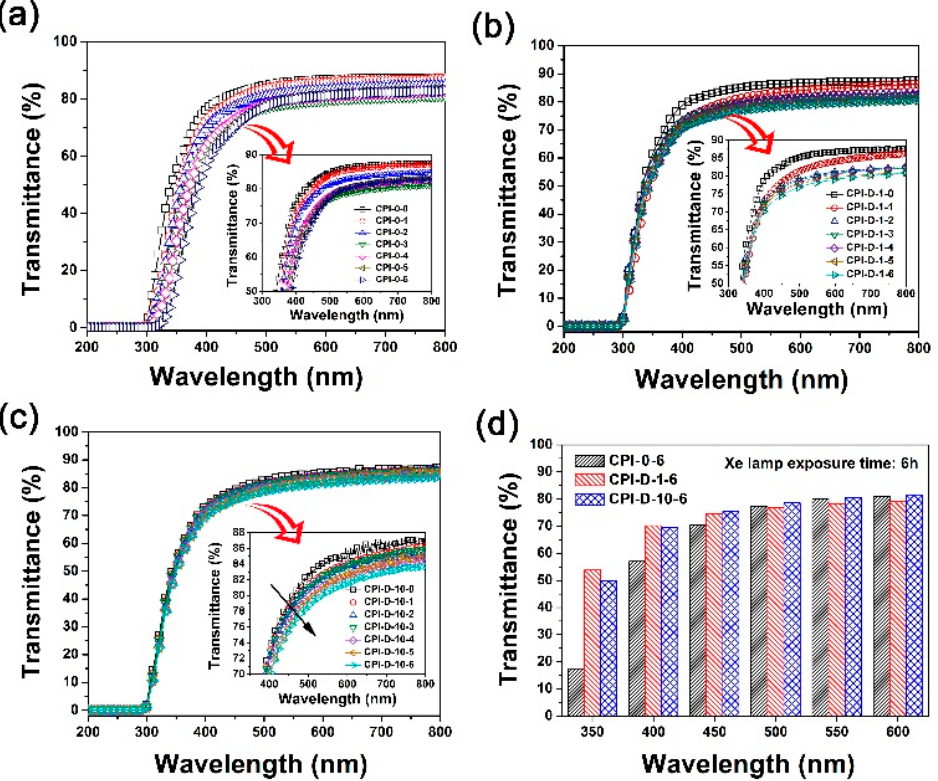
Figure 11. UV-Vis spectra of CPI-0 film and CPI-D nanocomposite films after Xenon lamp exposure. ( a ) CPI-0; ( b ) CPI-D-1 (0.1% 791); ( c ) CPI-D-10 (1.0% 791); ( d ) comparison of optical transmittances of the films after UV exposure for 6 h.